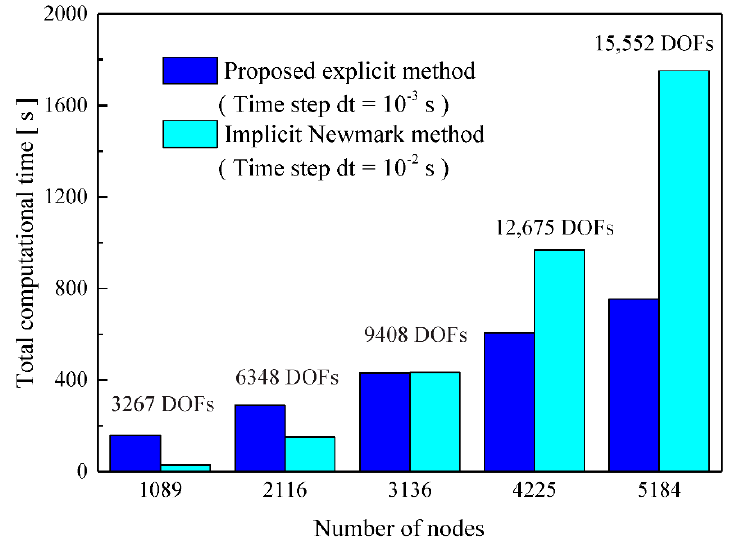
Figure 7. Comparison of computation time.